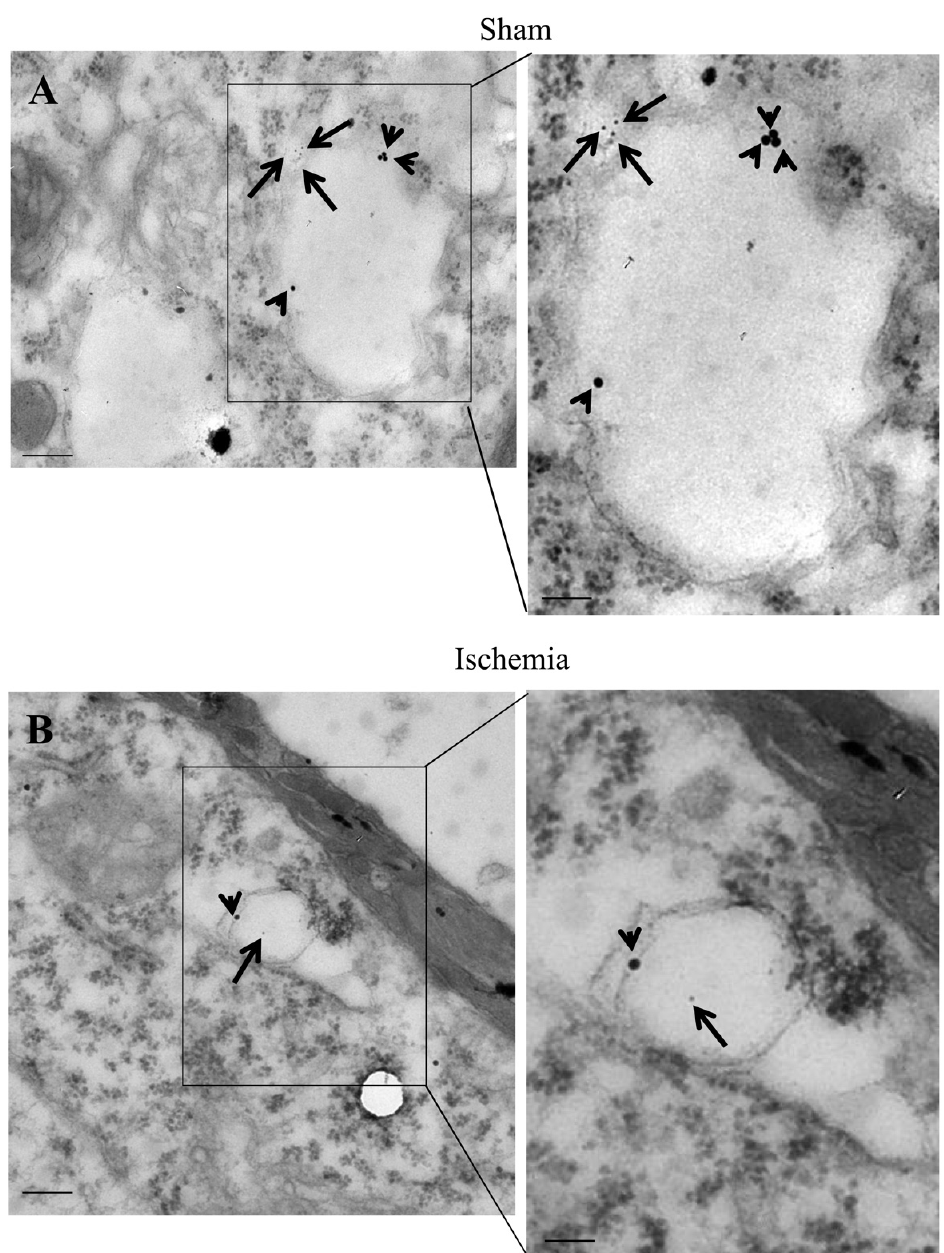
Figure 11. LC3 + P20S co-immuno-stained vacuoles. Representative TEM micrographs showing LC3 + P20S co-immuno-stained vacuoles within a cortical neuron from a ventral region homologous to area penumbra from a sham-operated mouse (Sham, A ) and a cortical neuron from ventral area penumbra from an ischemic mouse (Ischemia, B ). Arrowheads point to LC3 (20 nm) and arrows point to P20S (10 nm) immuno-gold particles within vacuoles. The insert highlights the LC3 + P20S immuno-gold particles within a vacuole. Scale bar = 0.2 μ m ( A , B ), 0.1 μ m (inserts).